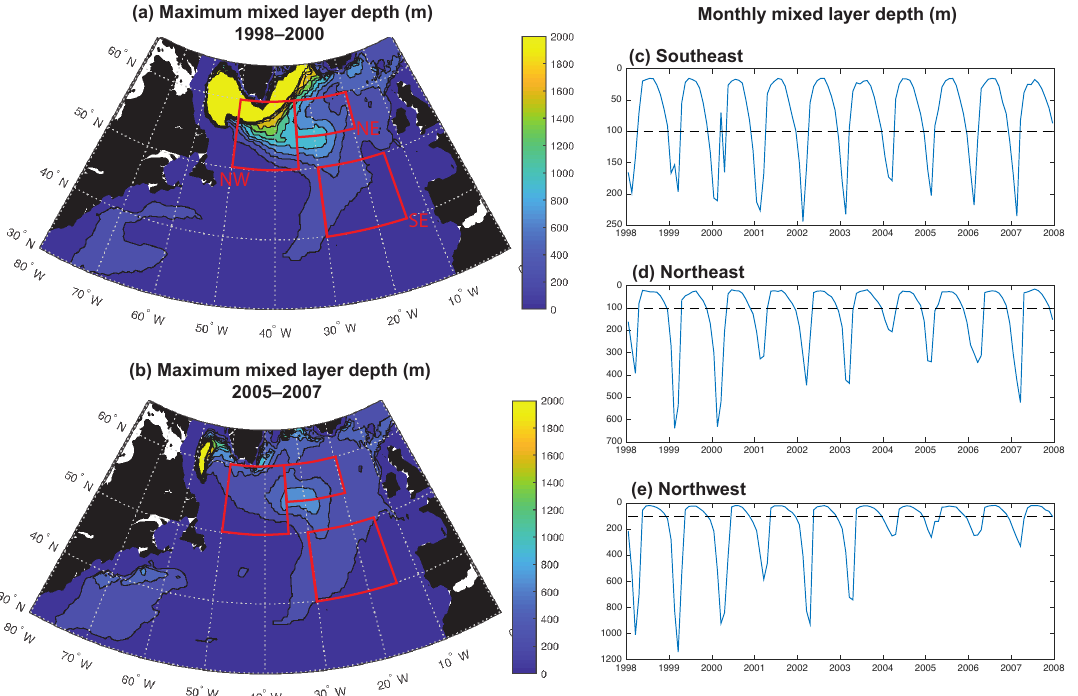
Figure 7. Maximum mixed layer depths for the (a) 1998–2000 mean and (b) 2005–2007 mean. Time series of monthly mixed layers for the (c) SE region, (d) NE region and (e) NW